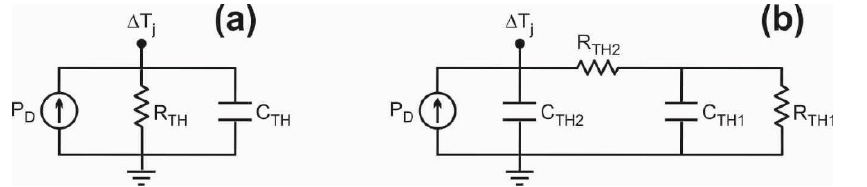
Figure 7. Equivalent thermal network included ( a ) in VBIC, Mextram 504, HICUM, and ( b ) in AHBT.